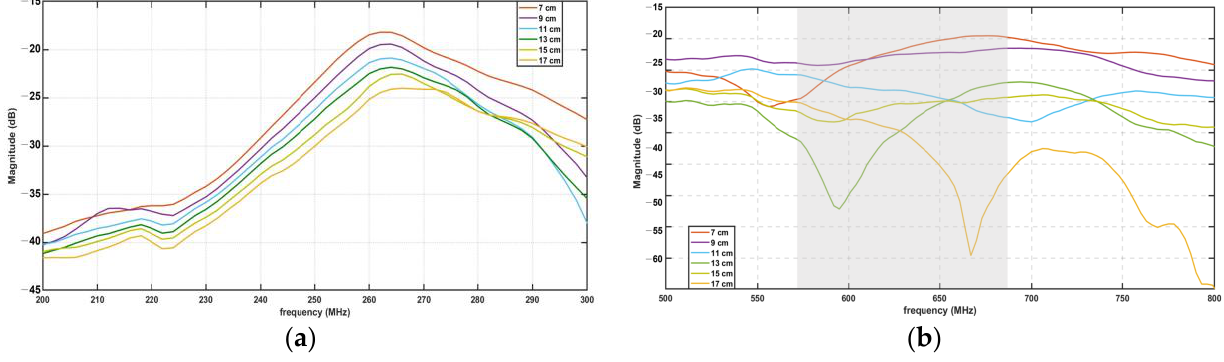
Figure 11. S 12 parameters of ( a ) 433 MHz antenna and ( b ) 915 MHz antenna measured at different distances from the transmitting antenna (7 to 17 cm).